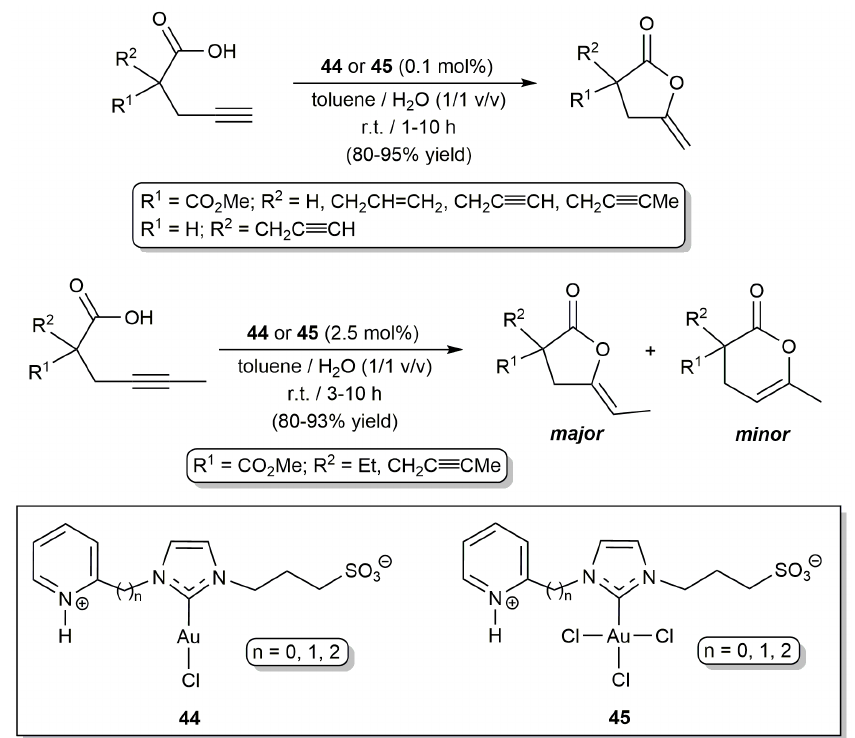
Scheme 16. Cyclosiomerization of different γ -alkynoic acids in a biphasic medium catalyzed by the water-soluble NHC-gold complexes 44-45 .